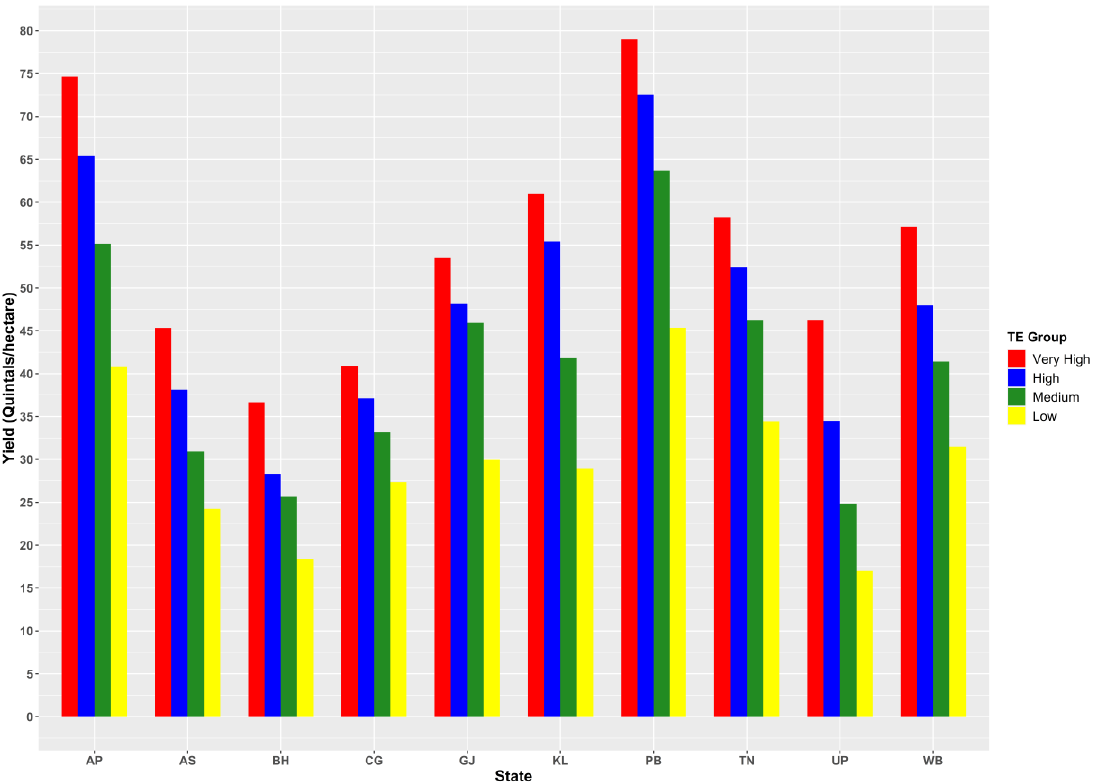
Figure 4. Yield of paddy (quintal/hectare) across various states and efficiency groups.